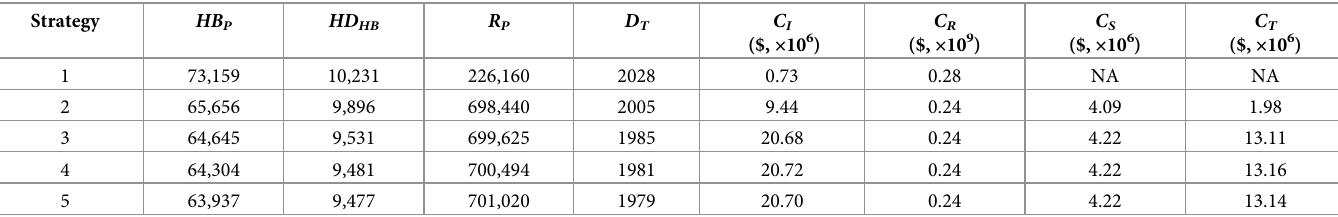
Table 4. Population stats in Manaus in 2027 under five different strategies. Strategy